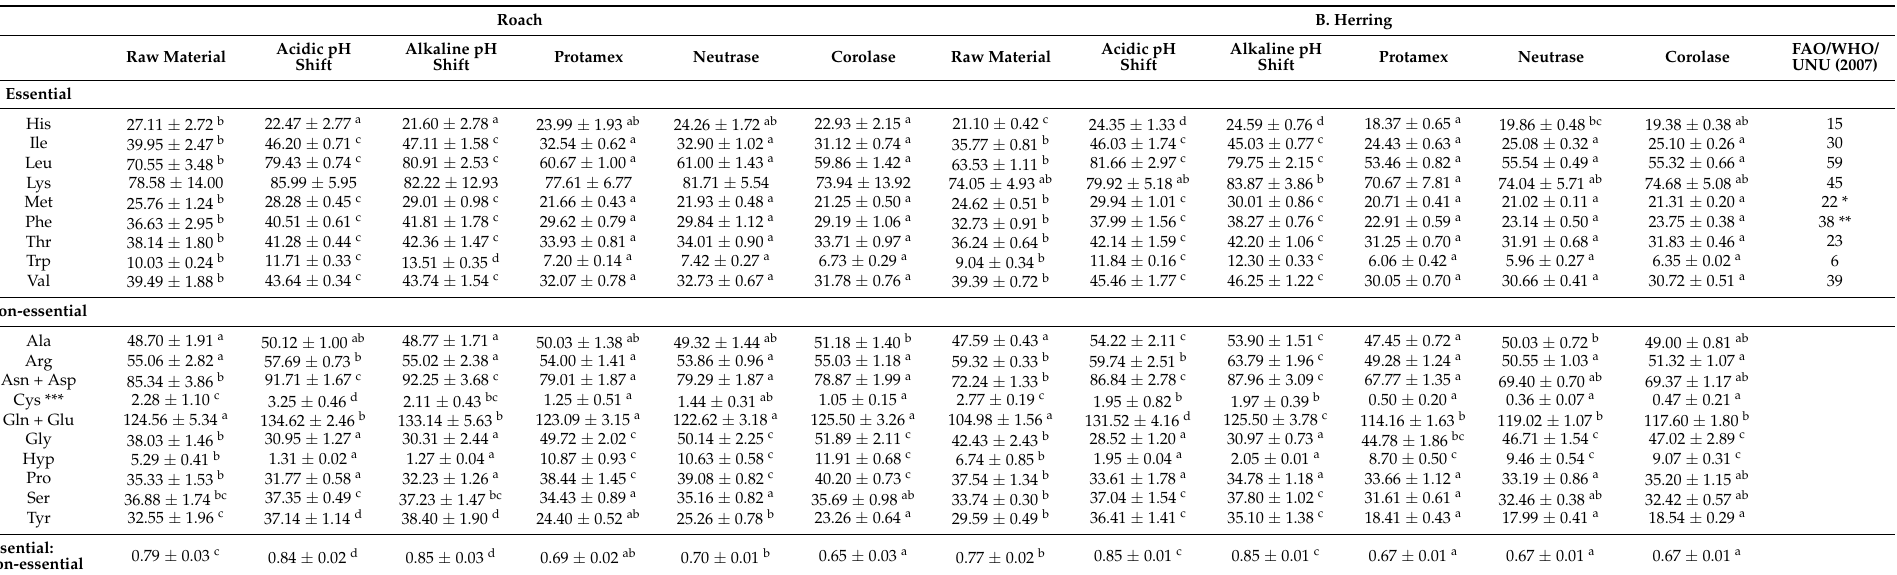
Table 2. Amino acids (mg/g protein) in protein isolates and hydrolysates from roach and B. herring, obtained using acidic or alkaline pH-shift process, or enzymatic fractionation using Protamex, Neutrase or Corolase. Different letters within the same row and raw material indicate a statistically significant difference ( p < 0.05). Roach B.